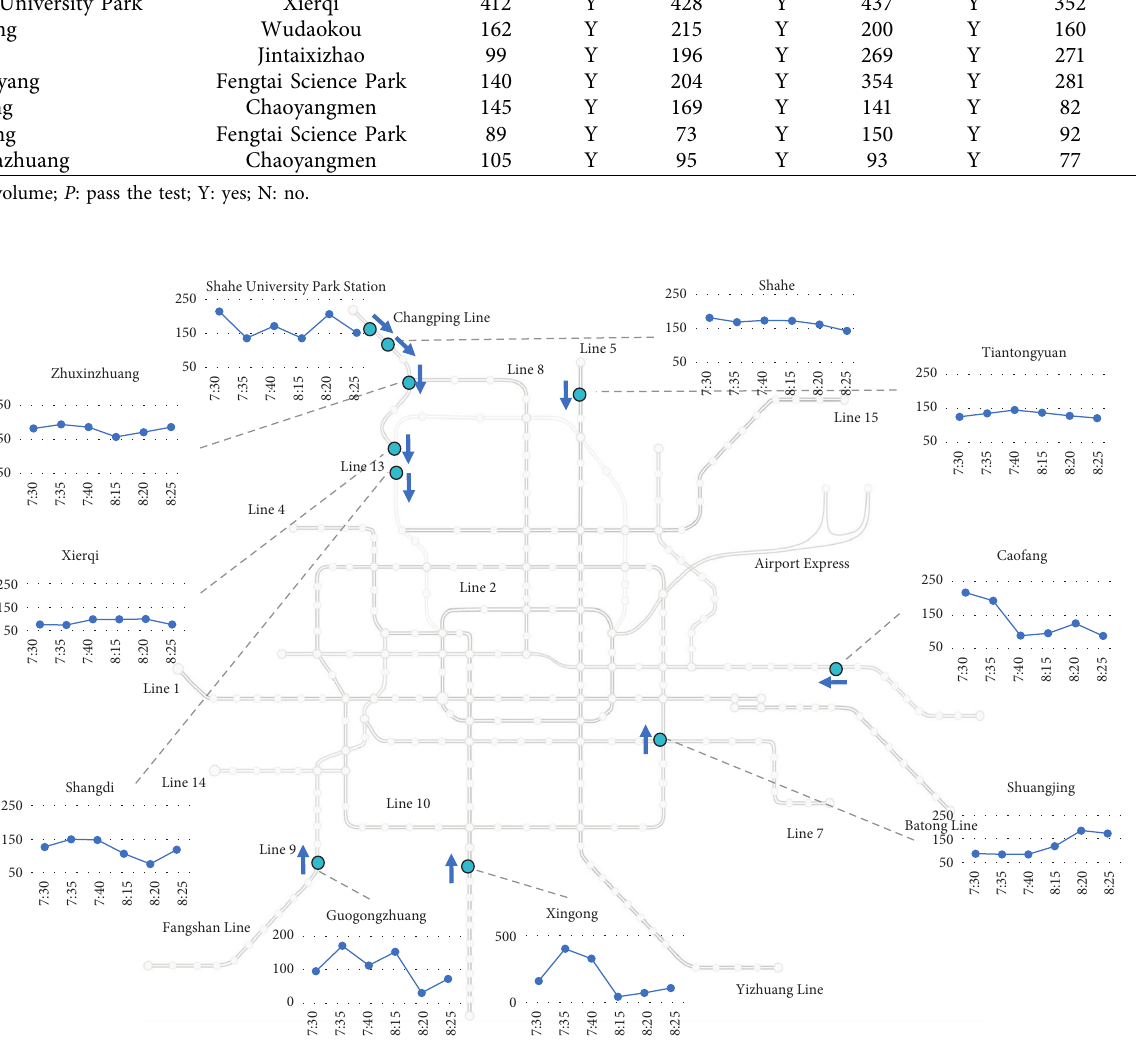
Figure 5: Waiting time analysis for